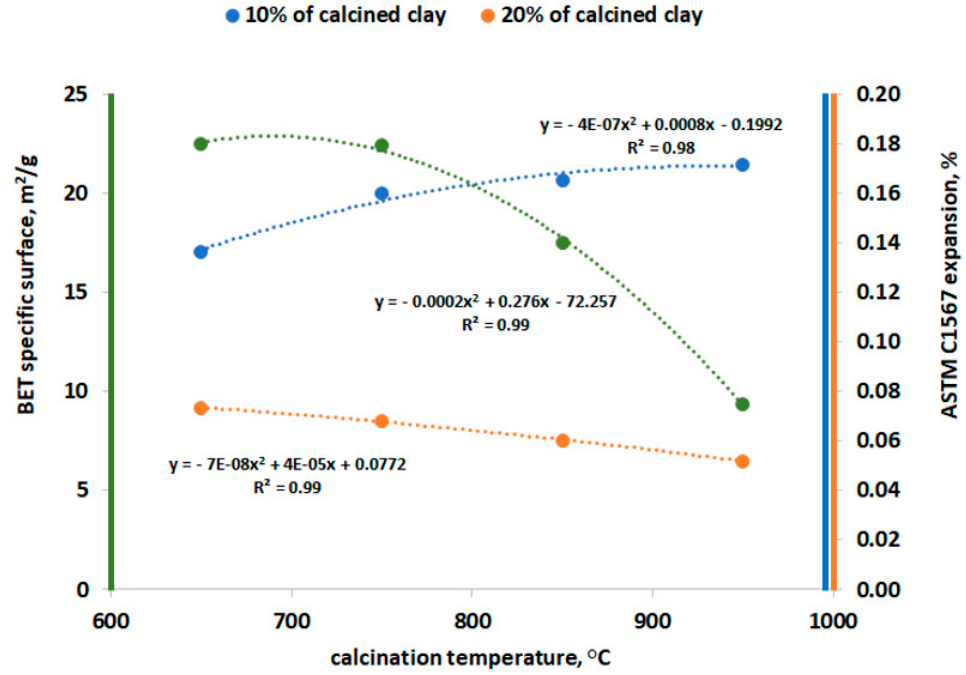
Figure 6. Results of the SSA of the calcined clay determined by BET method and expansion according to ASTM C1567 depending on calcination temperature.